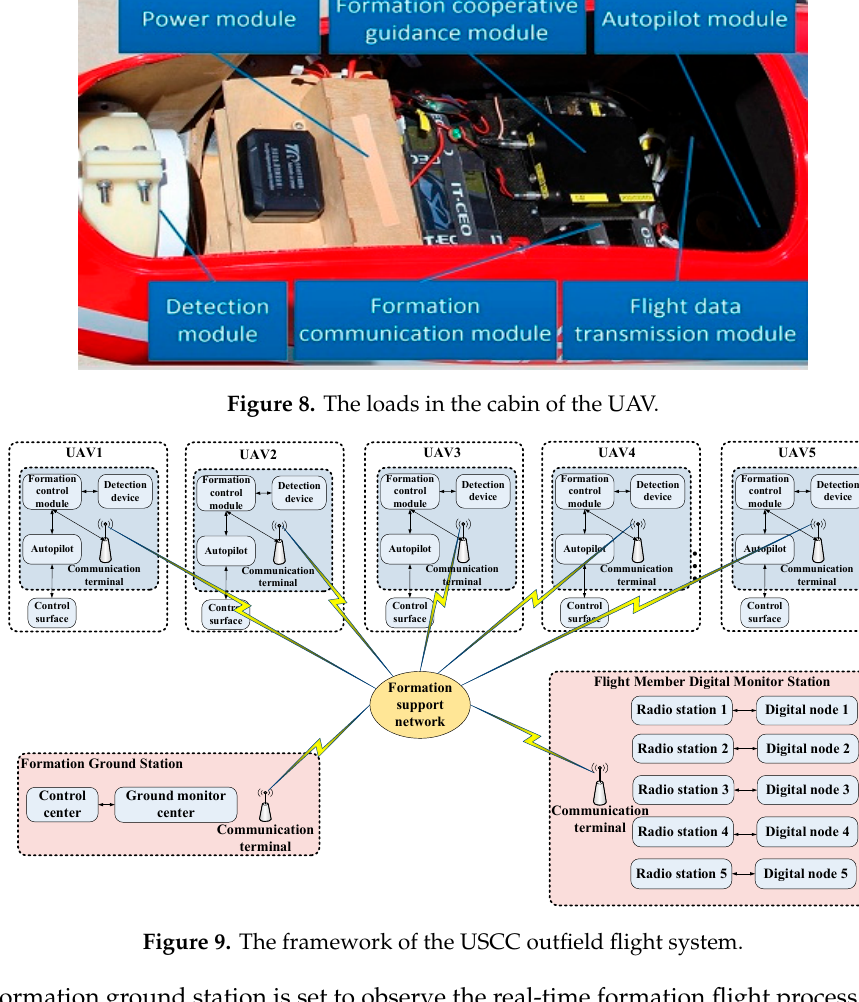
( d ) Figure 10. Configurations of five drones. ( a ) Designed lateral configuration; ( b ) Designed wedge configuration; ( c ) Real time lateral configuration; ( d ) Real time wedge configuration.